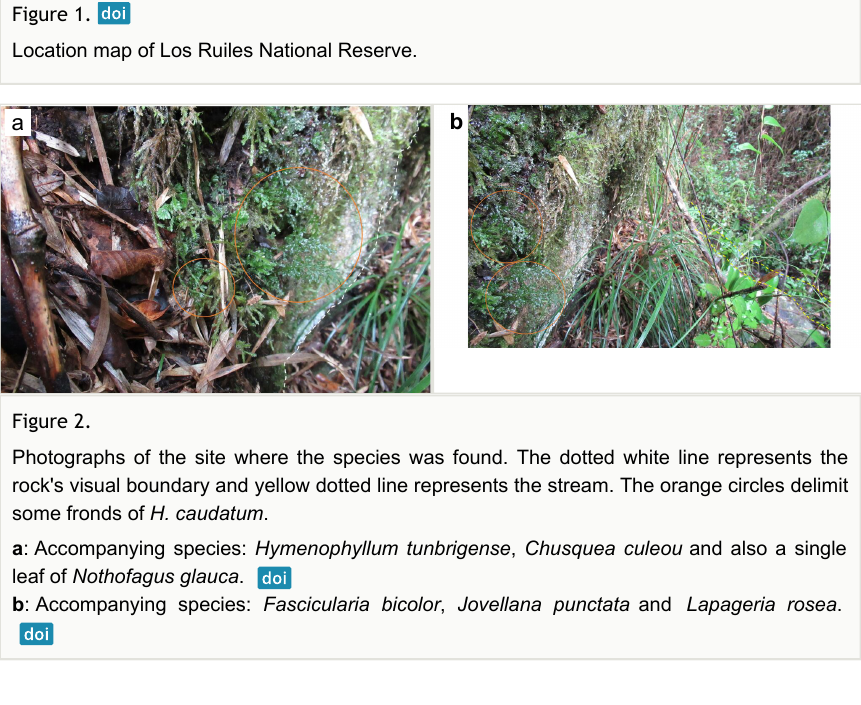
Figure 1. Location map of Los Ruiles National Reserve.